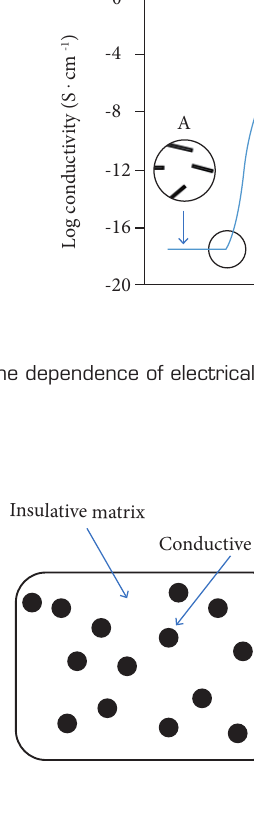
Figure 3. Filler distribution in polymer composite (a) at low